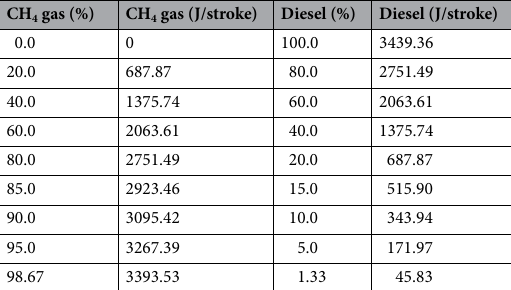
Table 3. The metal engine varied fuel mixture experimental